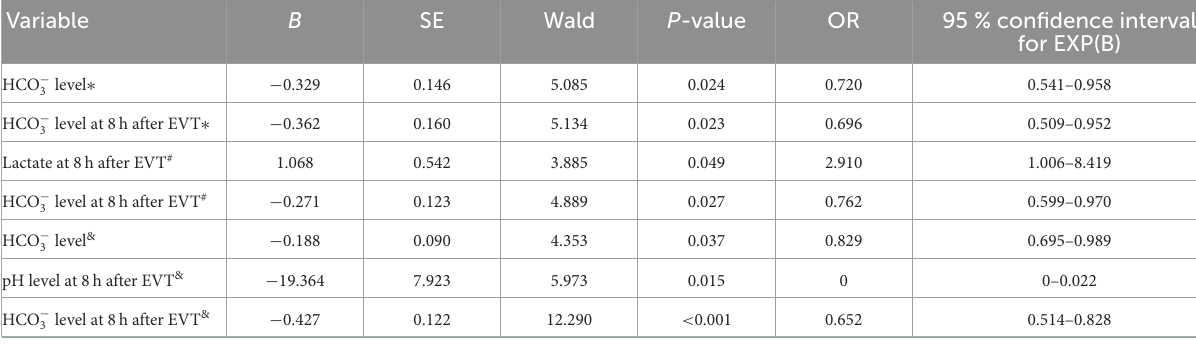
TABLE 3 Logistic regression analysis of independent factors for prognosis in patients with endovascular reperfusion therapies.